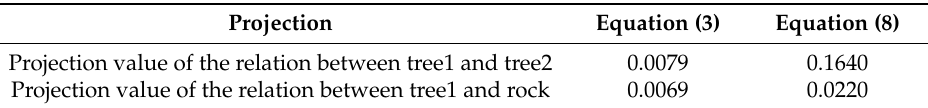
Figure 5. Spatial position of the ground objects of Figure 4. Table 1. Resulting projection values.